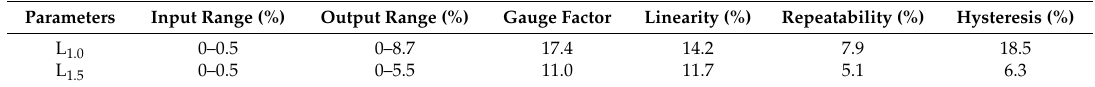
Table 2. Parameters of in situ strain monitoring of CNF/GFRP laminates.